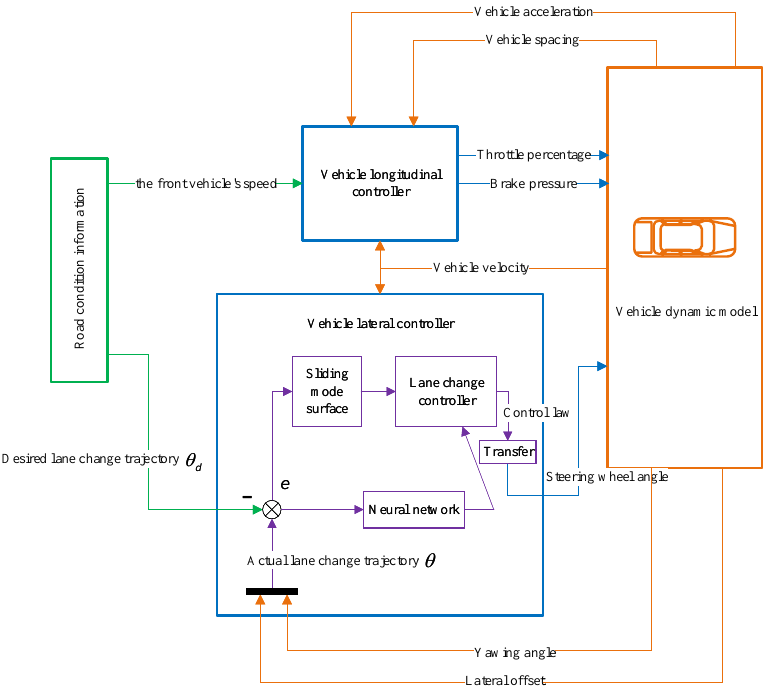
Figure 4. The framework overview of vehicle lateral and longitudinal integrated